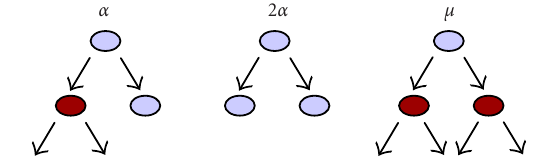
Figure 10. Three options for stem cell division. Three possible outcomes of stem cell activation and cell division are illustrated: an “ α ” division represents the classic asymmetric cell division with renewal of the mother cell and generation of a daughter that enters a downstream transit population. A “2 α ” cell divi- sion generates two identical stem cells, increasing the number of total stem cells by one. Finally, a “ µ ” division generates two cells that enter a downstream transit population, depleting the number of stem cells by one. The balance between “2 α ” and “ µ ” events determines whether a given stem cell pool will increase or decrease in